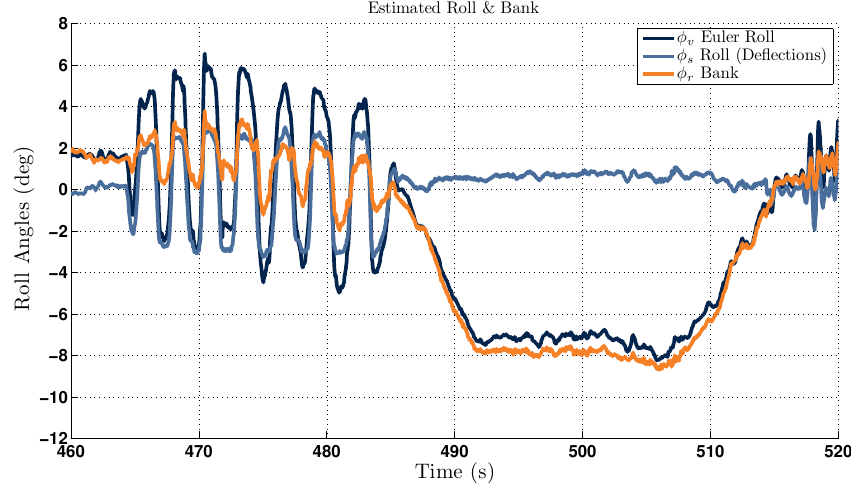
Figure 11. Bank estimate on the NCAT oval track 15-state cascaded